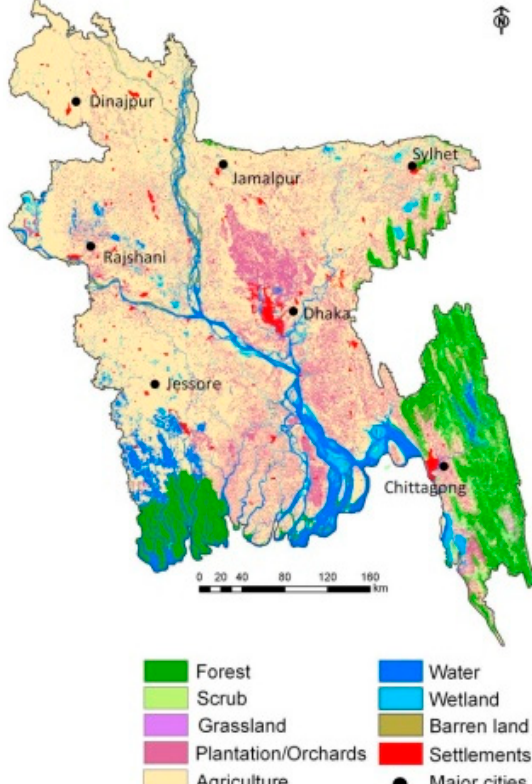
Figure 3. Agricultural regions in Bangladesh.